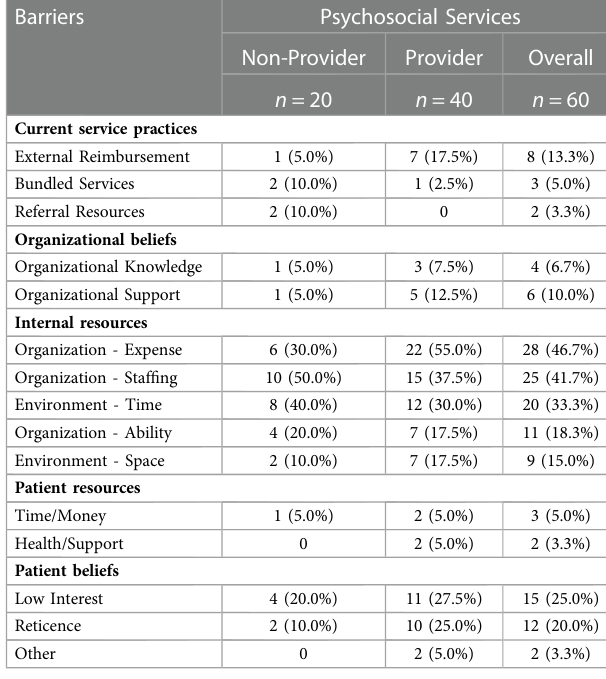
TABLE 3 summary of mental health related services at outpatient cardiac rehabilitation programs.